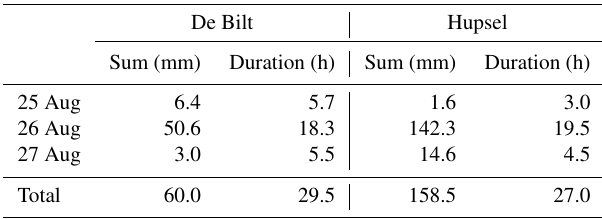
Figure 2. Synoptic situation for 26 August 2010, 12:00UTC. Table 1. Daily precipitation sum and duration on 25–27